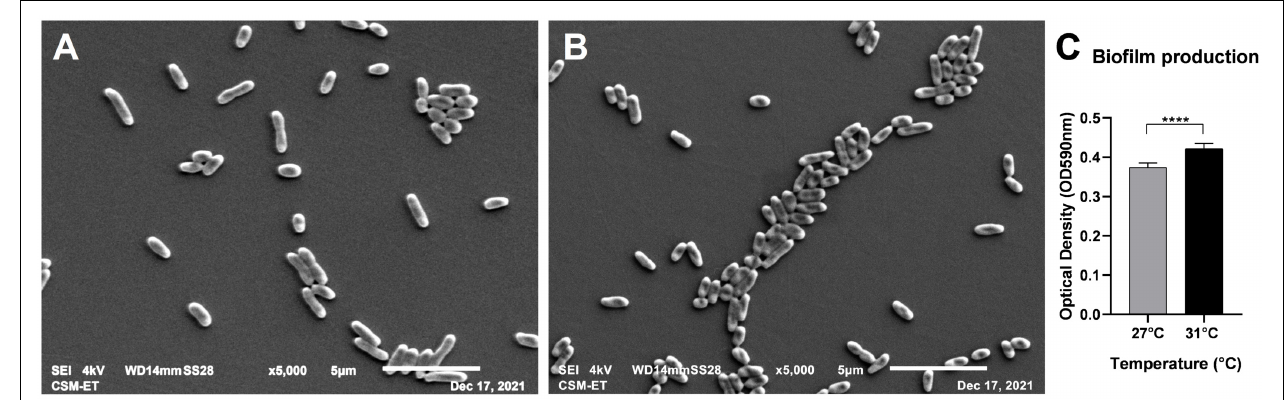
FIGURE 2 | Scanning electron micrographs presenting adhering V. parahaemolyticus at 27 ◦ C (A) and 31 ◦ C (B) . (Magnification × 5,000). Biofilm quantification of adhering bacteria to plastic (C) . **** p -values < 0.0001.